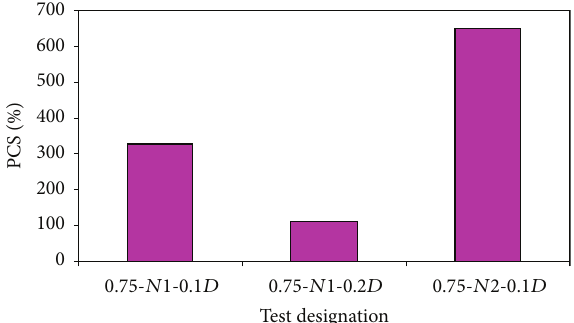
Figure 15: Percentage of Control in Settlement (PCS) for Series III ( 𝐷 = 0.75 𝑀